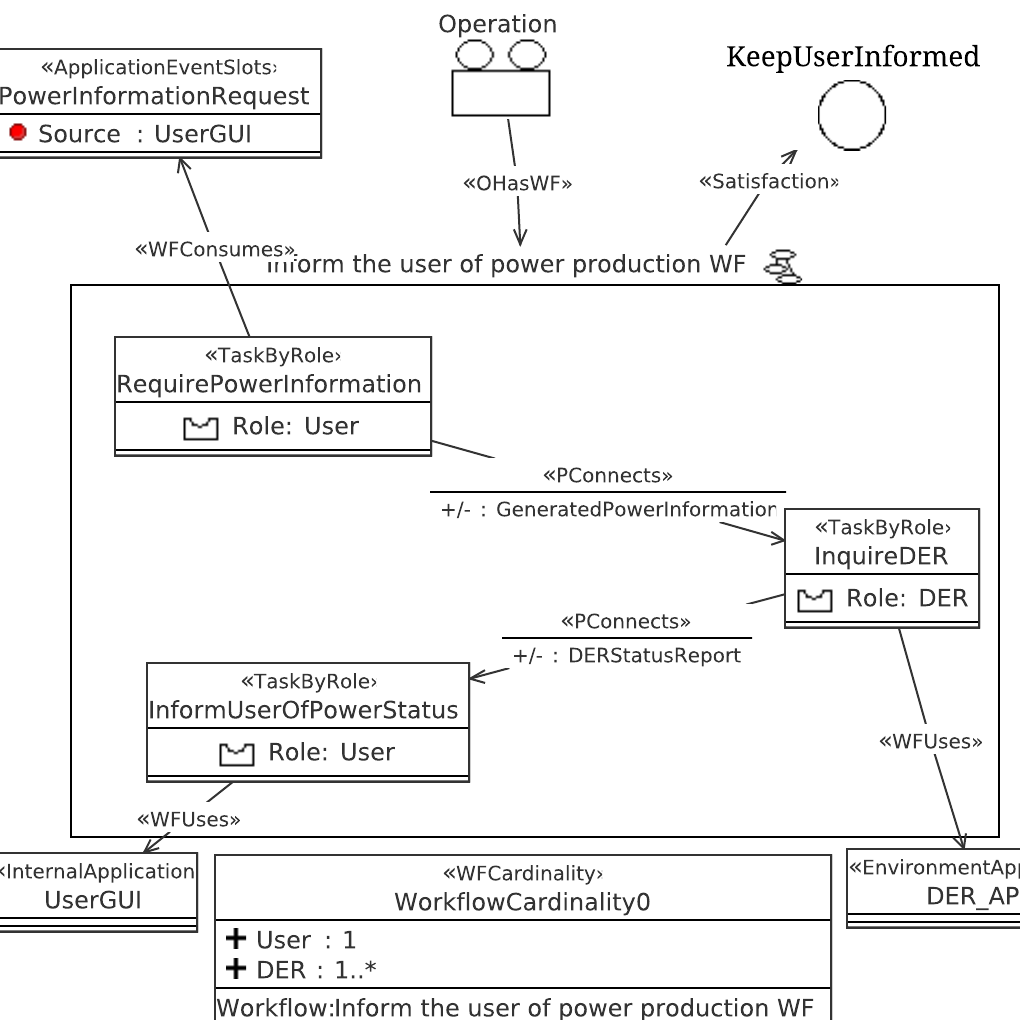
Figure 5. Workflow (WF) for informing the user on the current